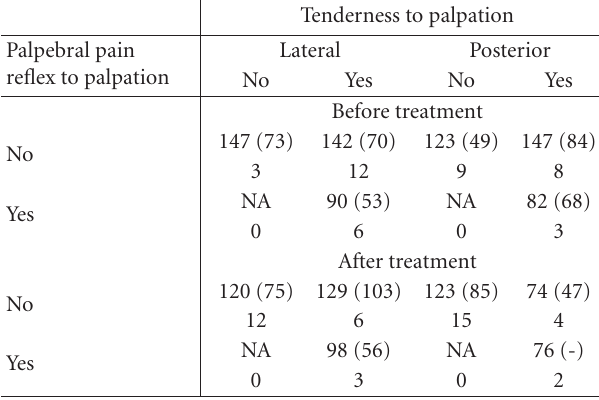
Table 3: Pressure-pain threshold in relation to tenderness and palpebral pain reflex to palpation before and 40 days after intra- articular administration of glucocorticoid in 21 female patients with chronic inflammatory temporomandibular joint (TMJ) disorders. Median (IQR) in kPa and number of observations. Absence or pres- ence of tenderness and palpebral pain reflex to digital palpation of the lateral and posterior (through the acoustic meatus) aspects of the TMJ were assessed with the mandible in rest position (all patients with a pain reflex had tenderness to palpation) and the pressure-pain threshold was recorded over the palpable lateral pole of the TMJ condyle, NA = not applicable and IQR = 75th–25th